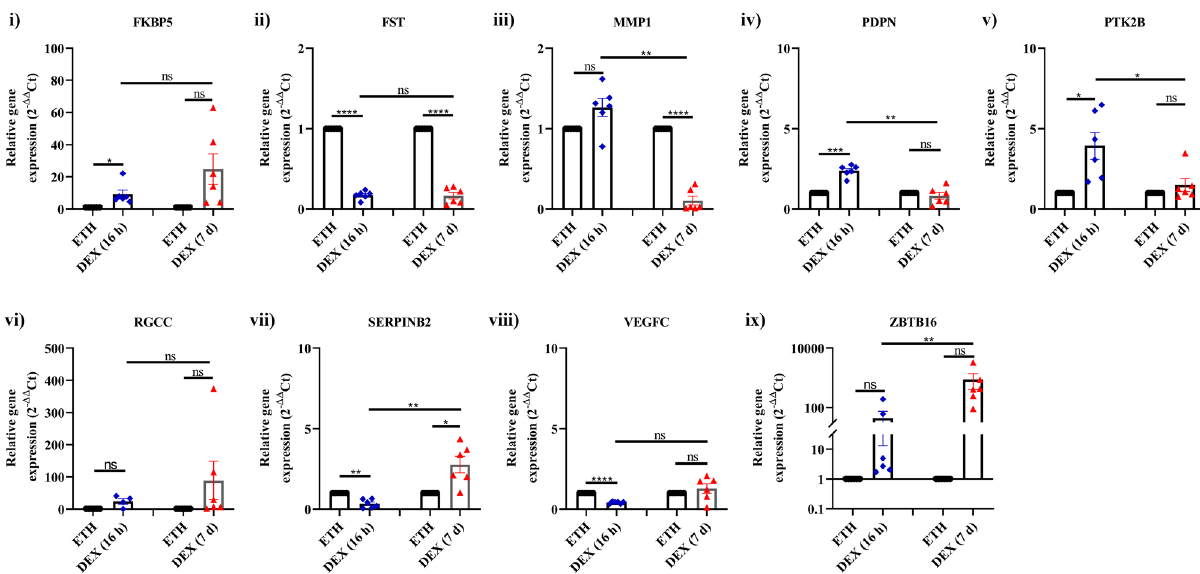
Figure 3. Validation of DEGs by qPCR. Expression profile of selected genes identified from RNA-seq validated by qPCR is shown. Primary HTM cells were treated with 100 nM DEX or 0.1% ETH for 16 h and 7 d. Gene expressions were normalized to GAPDH (16 h group) and ACTB (7 d group), and analyzed using the 2 −ΔΔCT method. The data is represented as mean ± SEM. * P < 0.01; ** P < 0.005; *** P < 0.001; **** P < 0.0001. Paired 2-tailed Student’s t